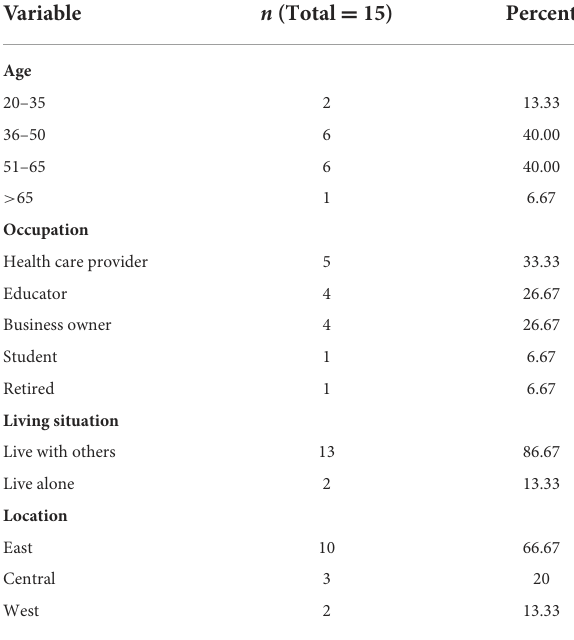
TABLE 1 Demographic characteristics of